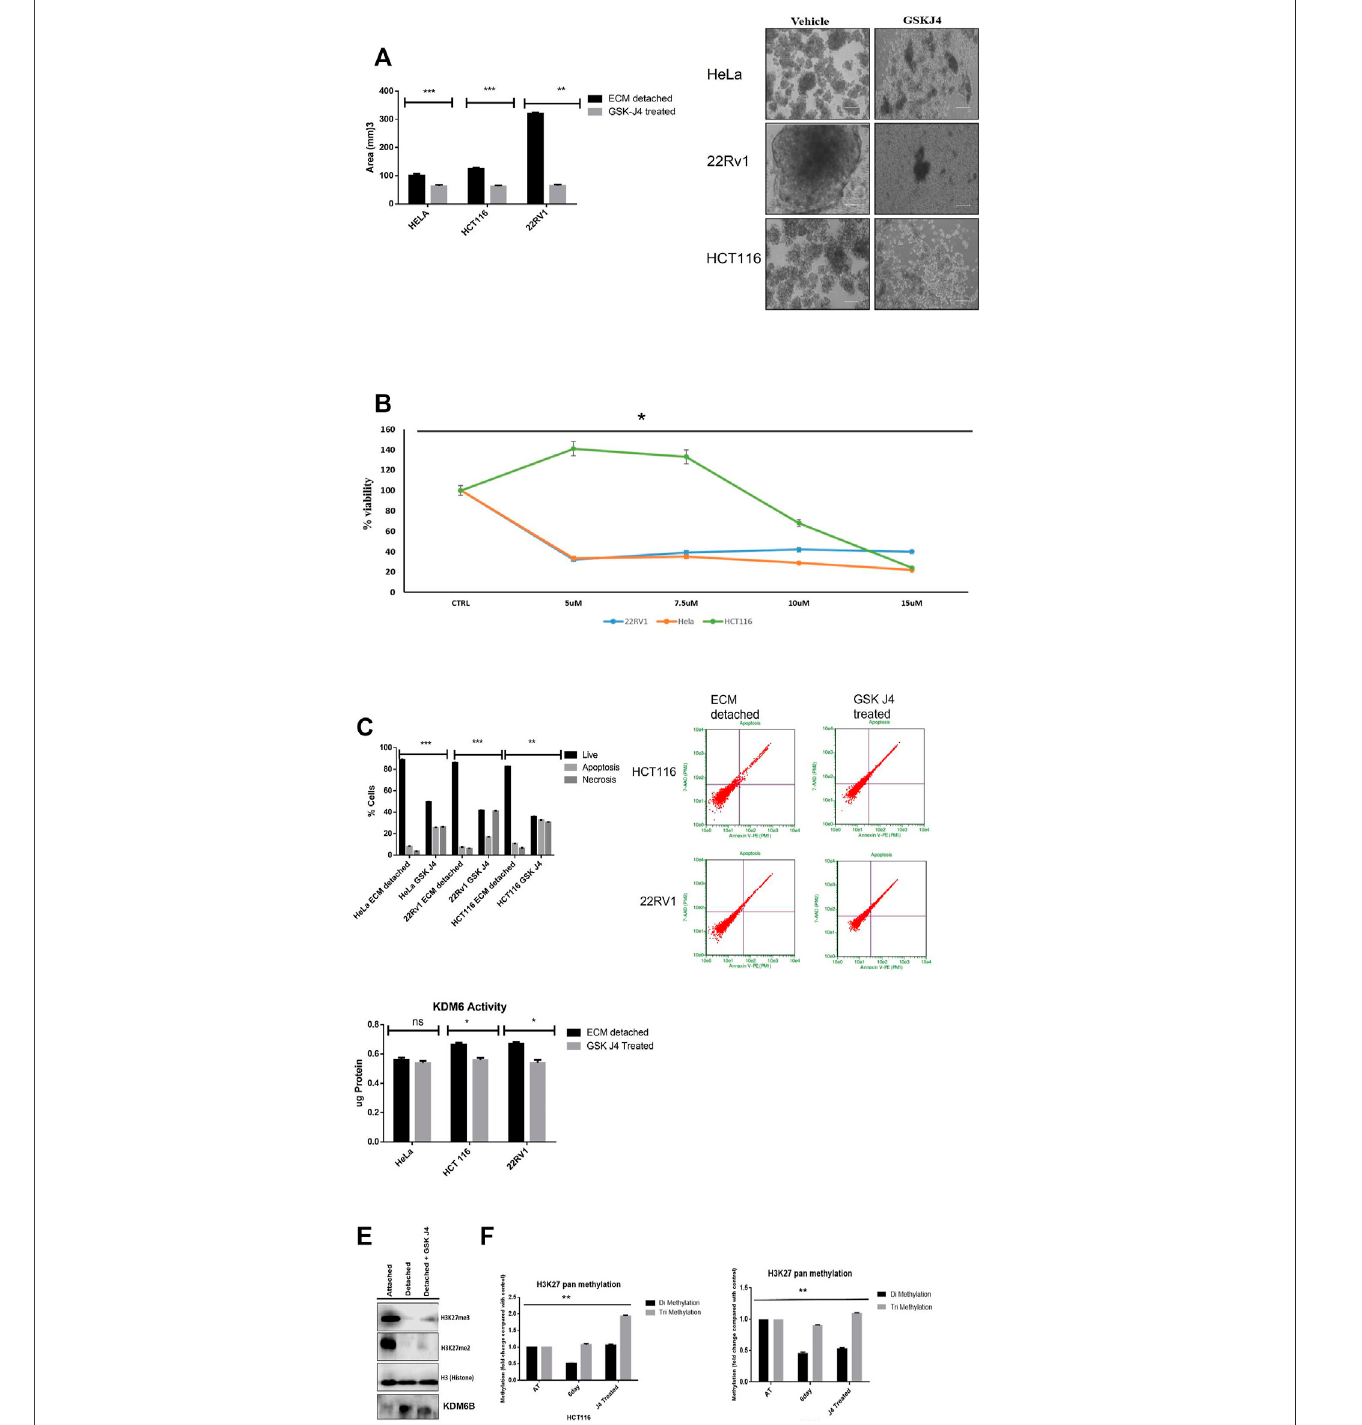
FIGURE 2 | KDM6A/B inhibition reduces the spheroid size and induces apoptosis. (A) Sphere formation assay HeLa, HCT116, and 22Rv1 cell lines were cultured in matrixdetachment forsixdays and simultaneouslytreated eitherwithGSK J4(5 µM forHeLaand 22Rv1, 10 µM forHCT116) orwithvehicle 0.1% DMSO(control).At the end of the treatment schedule, sphere images were captured using a Nikon inverted light microscope, and images were analyzed for size measurement by ImageJ software N = 8. Histogram plots were plotted for average size in all conditions. (B) HeLa, HCT116, and 22Rv1 cell lines were cultured in matrix detachment for six daysandsimultaneouslytreatedwithdifferentGSKJ4orwithvehicle0.1%DMSO(control).CellproliferationwasmeasuredusingWST-1,andIC50wascalculated. (C) ApoptosisassayHeLa,HCT116, and22Rv1celllineswereculturedinmatrixdetachmentforsixdaysand simultaneouslytreatedeitherwithGSKJ4(5 µMforHeLaand